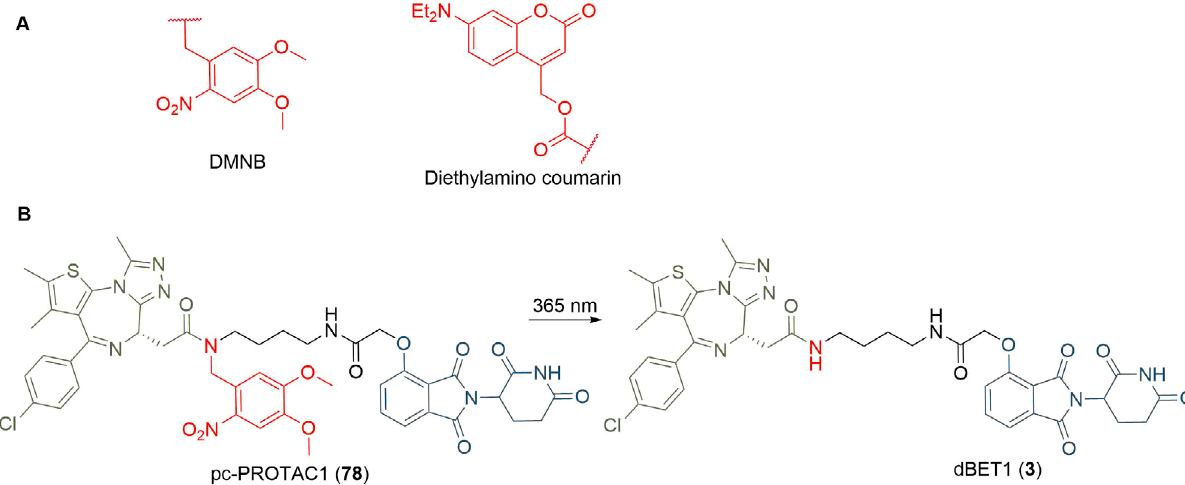
Figure 15. A. Structures of photocleavable groups DMNB and diethylamino coumarin; B. irradiation of DMNB-protected PROTAC 78 at 365 nm releases potent BET degrader dBET1